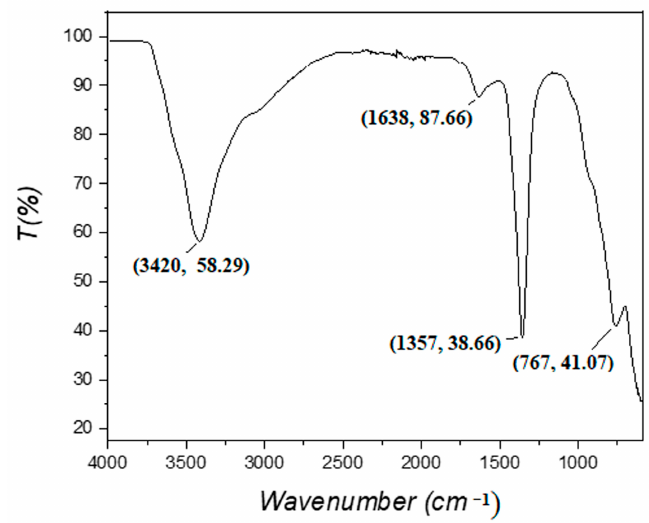
Figure 3. IR spectrum of the LDH synthesized.